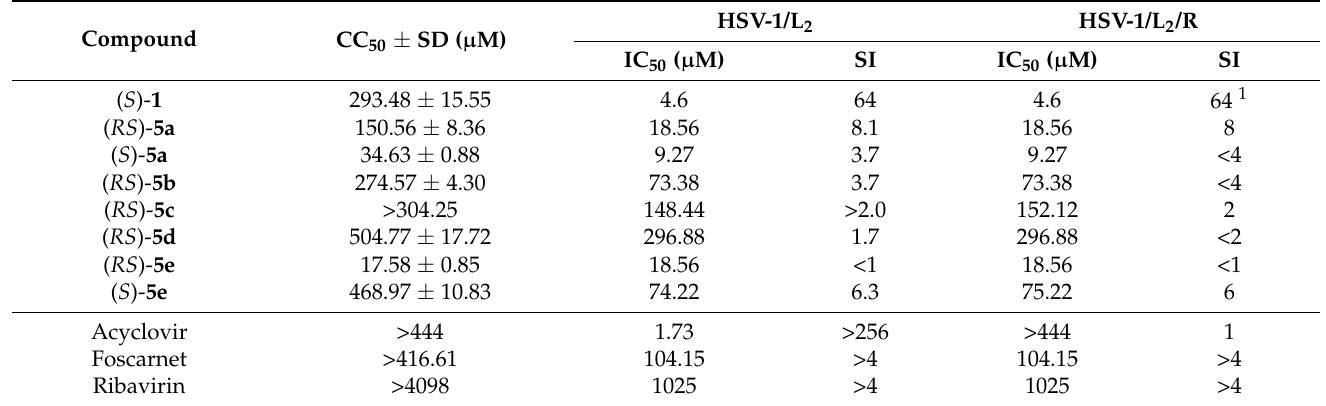
Table 1. Cytotoxicity and inhibitory activity of compounds 5a – e against herpes simplex virus type 1 (HSV-1) strains in the Vero E6 cells.